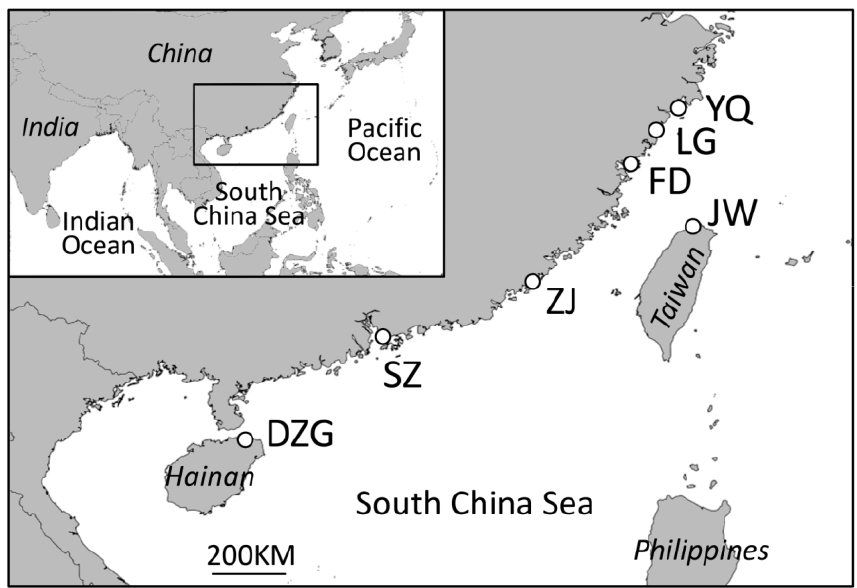
Figure 1. The population samples of K. obovata in this study. The upper left panel shows the relative position of the study